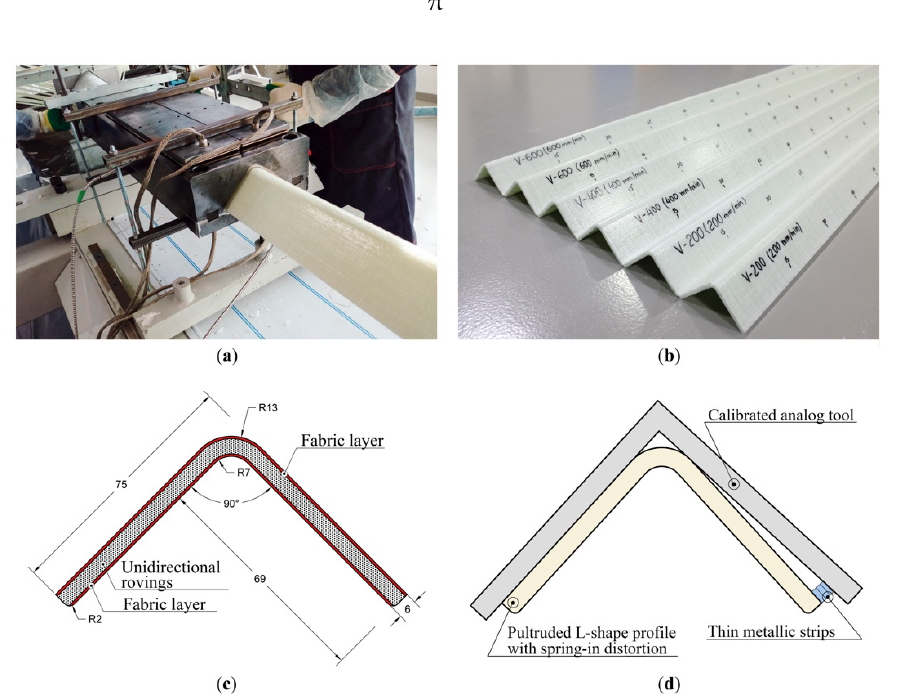
Figure 1. Pultrusion process setup: ( a ) Pultrusion of an L-shaped profile; ( b ) L-shaped profiles pultruded at pulling speeds of 200, 400, and 600 mm/min; ( c ) The cross-section of a 75 mm × 75 mm × 6 mm L-shaped pultruded profile and the position of the unidirectional rovings and fabric layers; ( d ) Schematic representation of the spring-in measurement process.